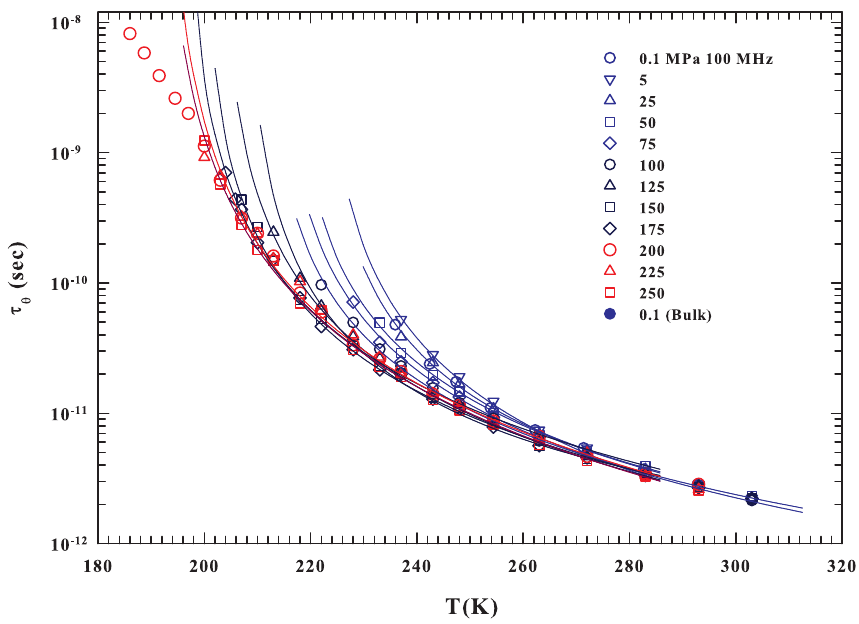
Figure 5. The reorientational correlation time τ θ isobars, corresponding to the R 1 illustrated in Figure 3, evaluated according to the current NMR theoretical models [60–62]. The dotted lines correspond to a data fitting in terms of the mode coupling theory scaling law for critical